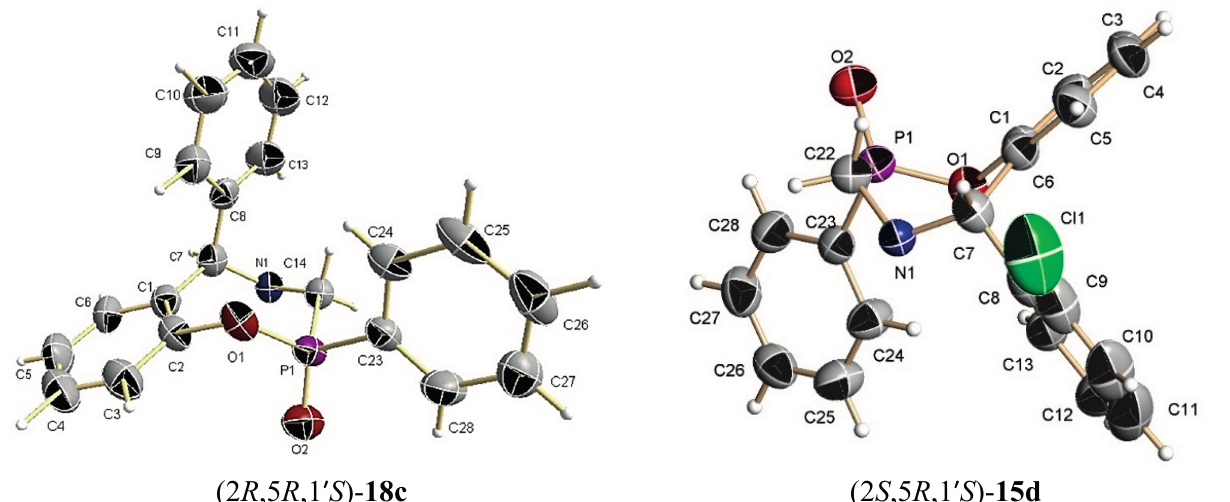
Figure 5. Chair conformations for 16a , 16b , and 18c . Boat conformation for 15d [34].